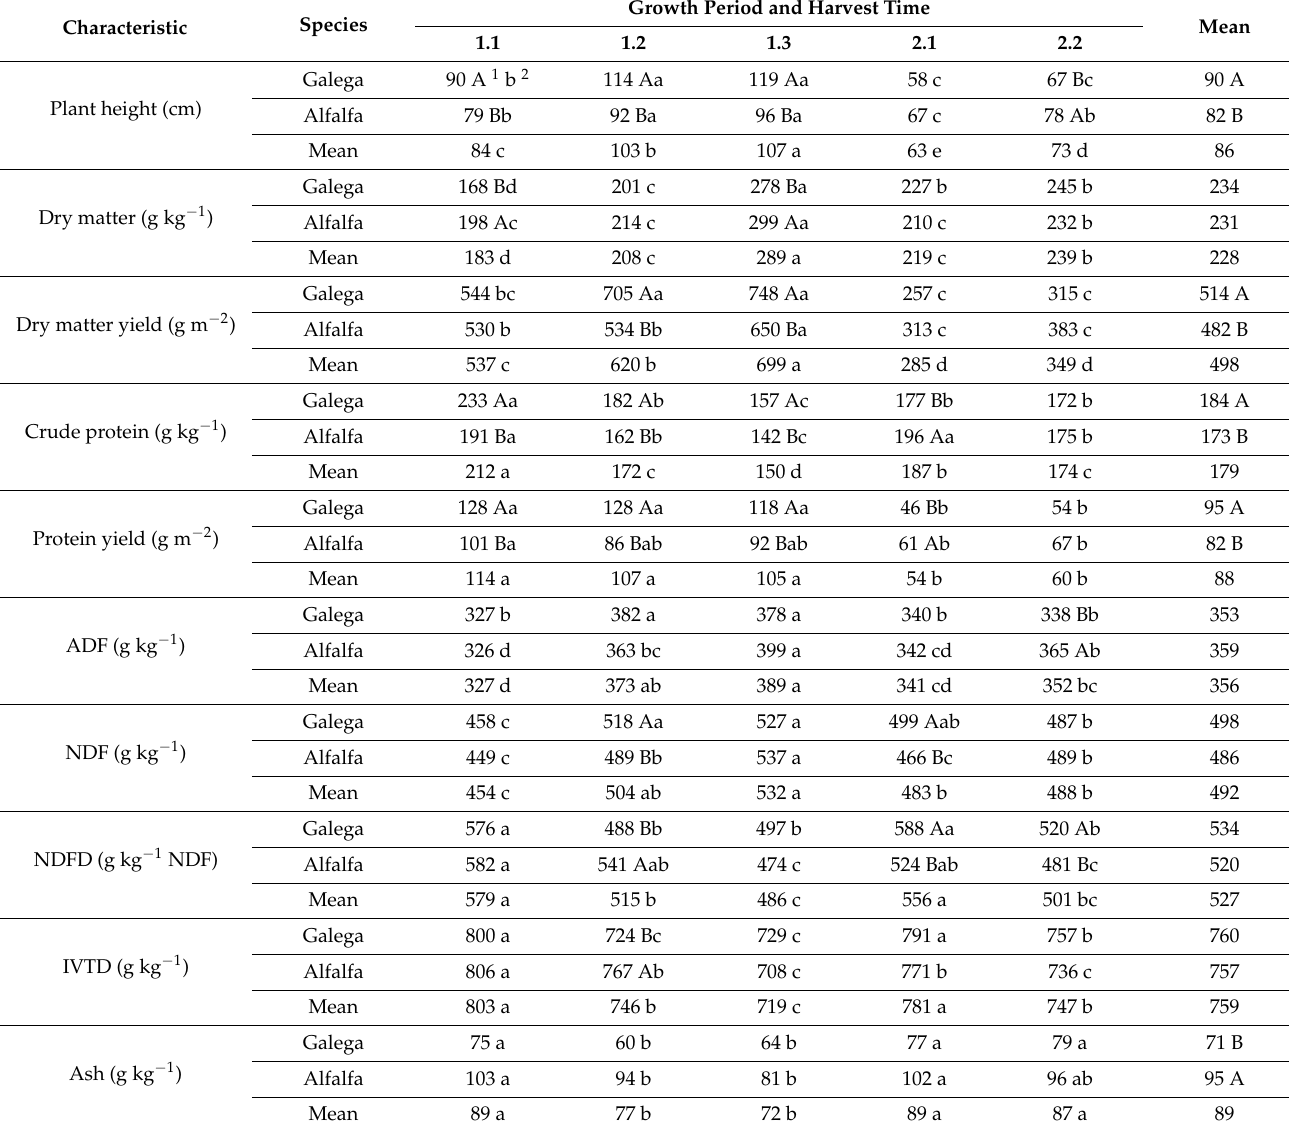
Table 5. Plant height, dry matter concentration and yield, crude protein concentration and yield, ADF, NDF, NDFD, IVTD, and ash concentrations in the whole plants of galega and alfalfa in two growth periods and different harvest times (means over two